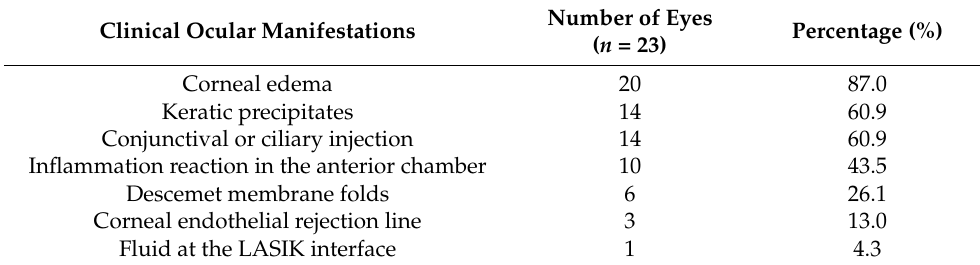
Table 4. Clinical ocular manifestations after COVID-19